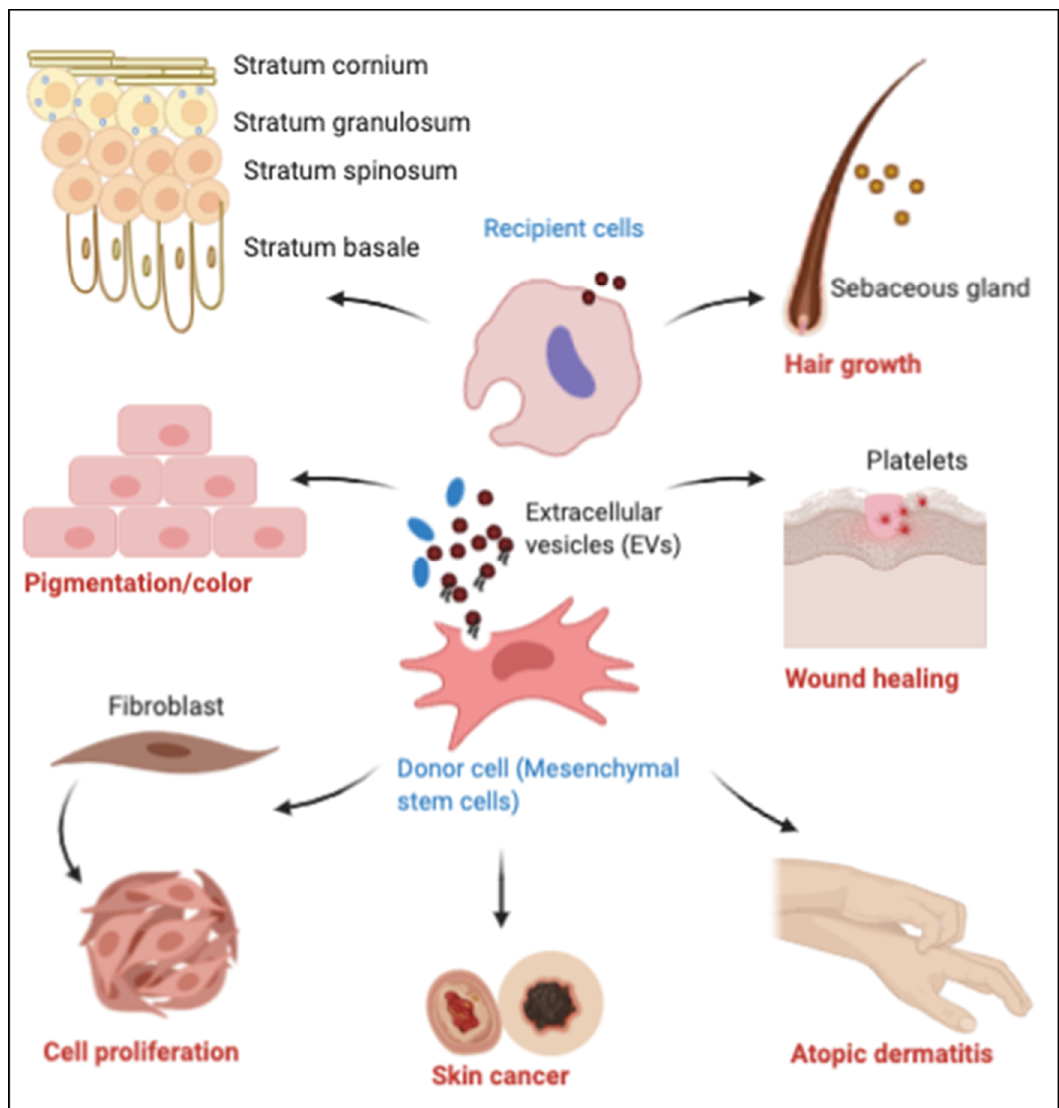
Figure 4. Therapeutic role of EVs (exosomes) in cutaneous diseases. Exosomes with specific cargo can attenuate deregulated changes associated with pathogenesis of different skin diseases such as wound healing, hair problems, cell proliferation, pigmentation and cancer development.